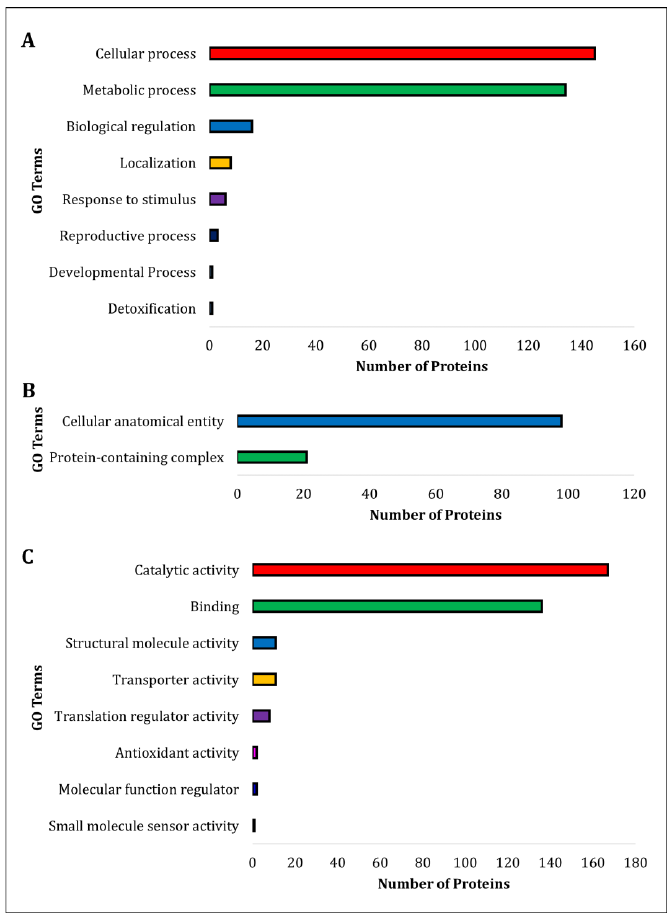
Figure 2. Functional annotation . The identified proteins from S. pasteuri culture supernatant were submitted to the ComparativeGO database, and the proteins were classified according to Biological process ( A ), Cellular component ( B ), and Molecular function ( C ). ( A ) Proteins were mainly involved in cellular and metabolic activities. ( B ) The majority of proteins were present in cellular anatomical entities and protein-containing complexes. ( C ) The major proteins were associated with catalytic and binding activities.